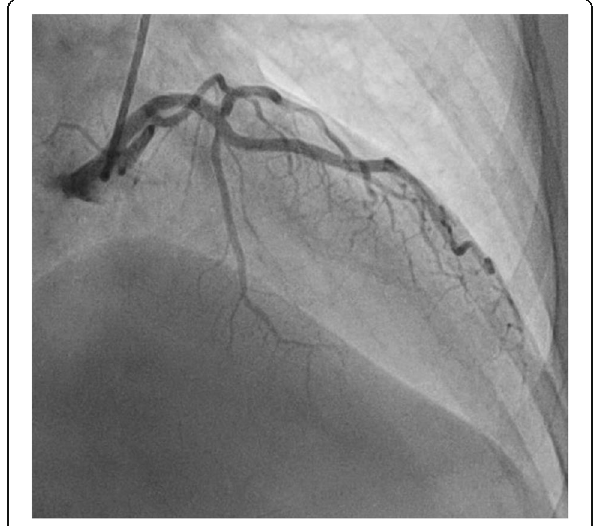
Fig. 2 RAO cranial view showing a short LAD simulating type 1 LAD and giving rise to a single septal and two diagonal